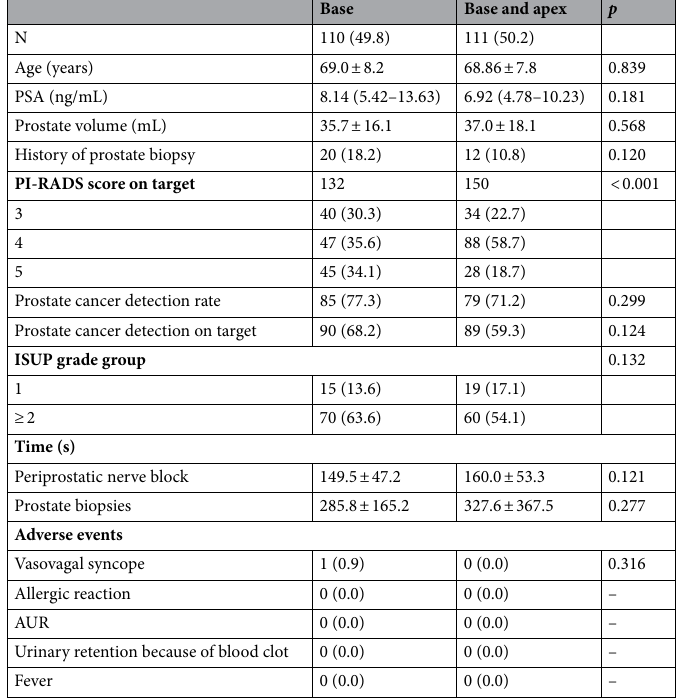
Table 1. Baseline characteristics of groups according to the site of the PNB. Data are expressed as number (%), mean ± standard deviation, and median (IQR range). AUR acute urinary retention, ISUP International Society of Urological Pathology, IQR interquartile, PI-RADS prostate imaging-reporting and data system, PNB periprostatic nerve block, PSA prostate-specific antigen.